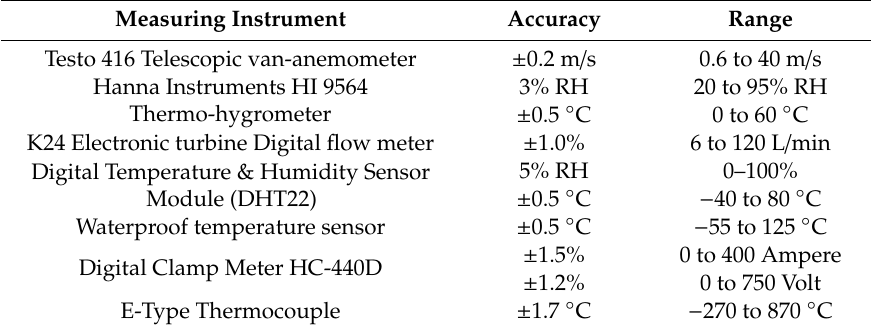
Table 1. Technical specifications of the instruments used in the experimental